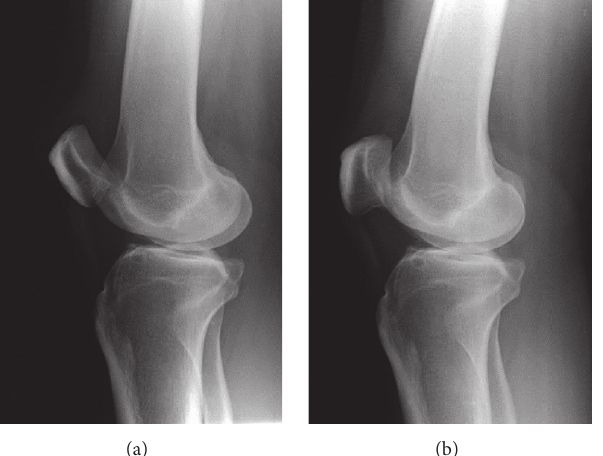
Figure 2: Pre- and postreduction lateral radiographs show superior dislocation of the patella. (a) showed high-riding patella with inferior patellar osteophyte locked to osteophyte at the superior aspect of femoral condyle. (b) showed normal position of patella.